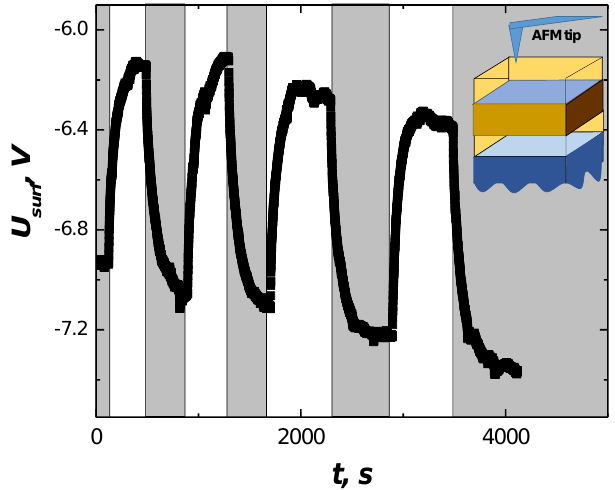
Figure 5. The dynamics of the surface potential of the heterostructure during several on/off cycles of green illumination (80 mW/cm 2 ). An illustration of the AFM-based Kelvin probe surface potential measurements is shown in the insert.